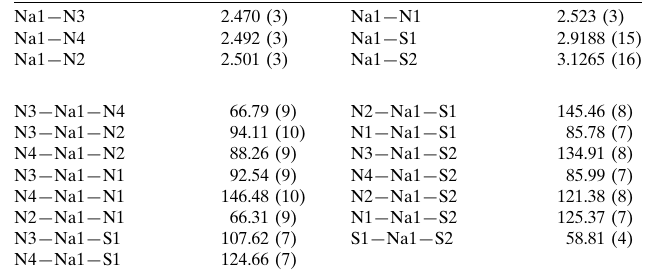
Selected geometric parameters (A˚ , (cid:1)